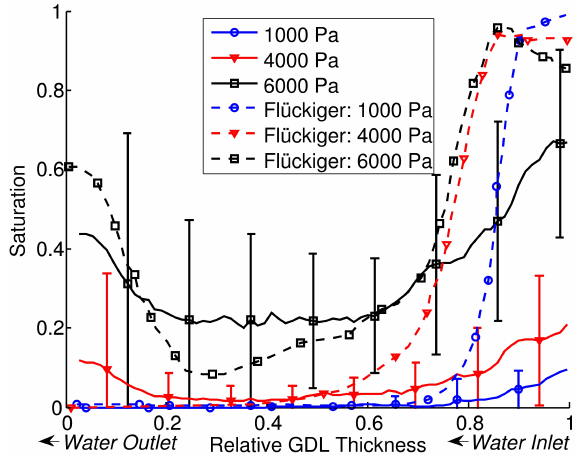
Figure 6. Saturation profile over the thickness of a Toray TGP-H-060 GDL from the water inlet interface (right) to the water outlet interface (left). The calculated data for three different pressure levels are compared to synchrotron visualization data by Fl¨uckiger et al. [34] for the same type of GDL.